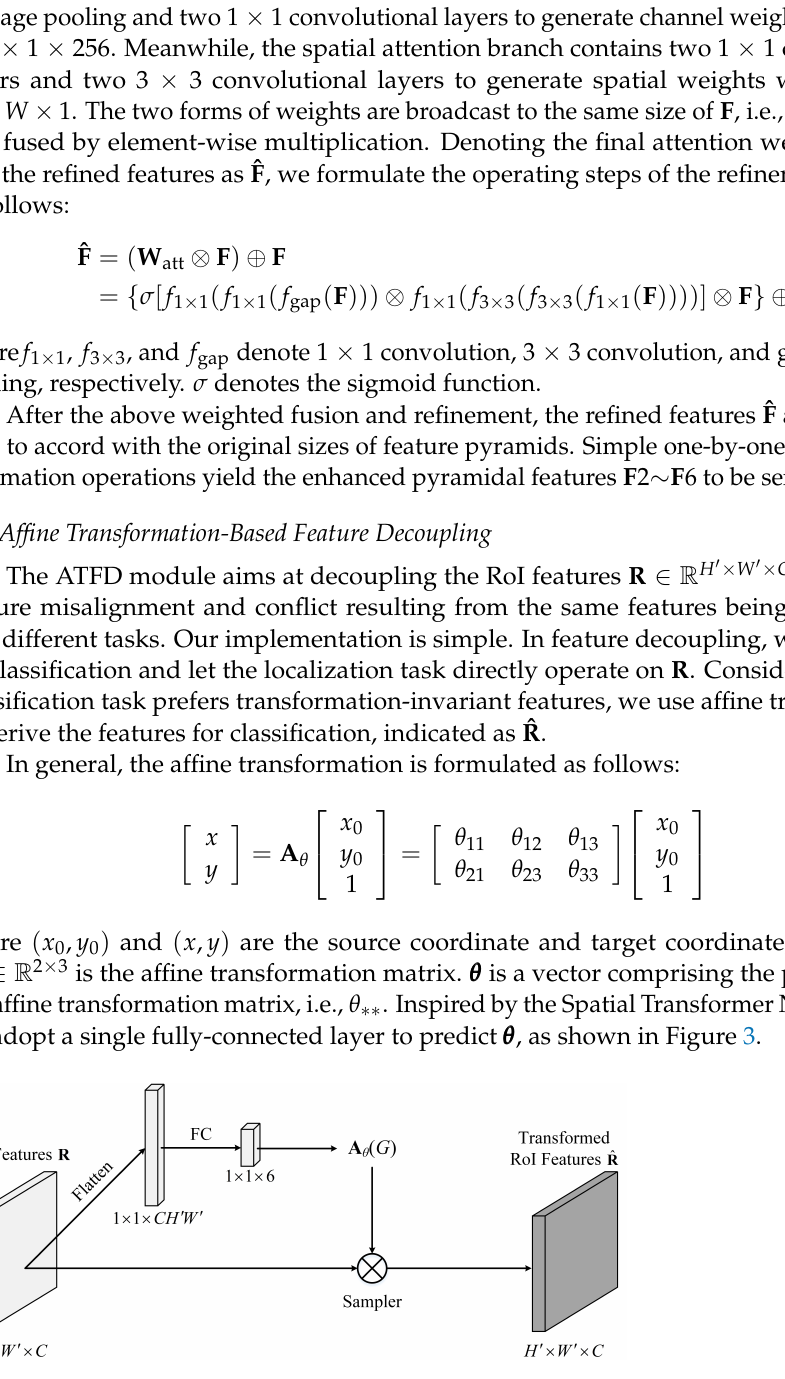
Figure 3. The architecture of the proposed ATFD module. FC denotes a fully-connected